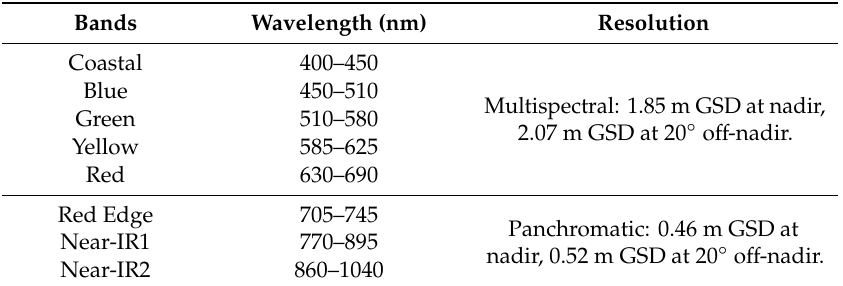
Table 1. WorldView-2 spectral details.